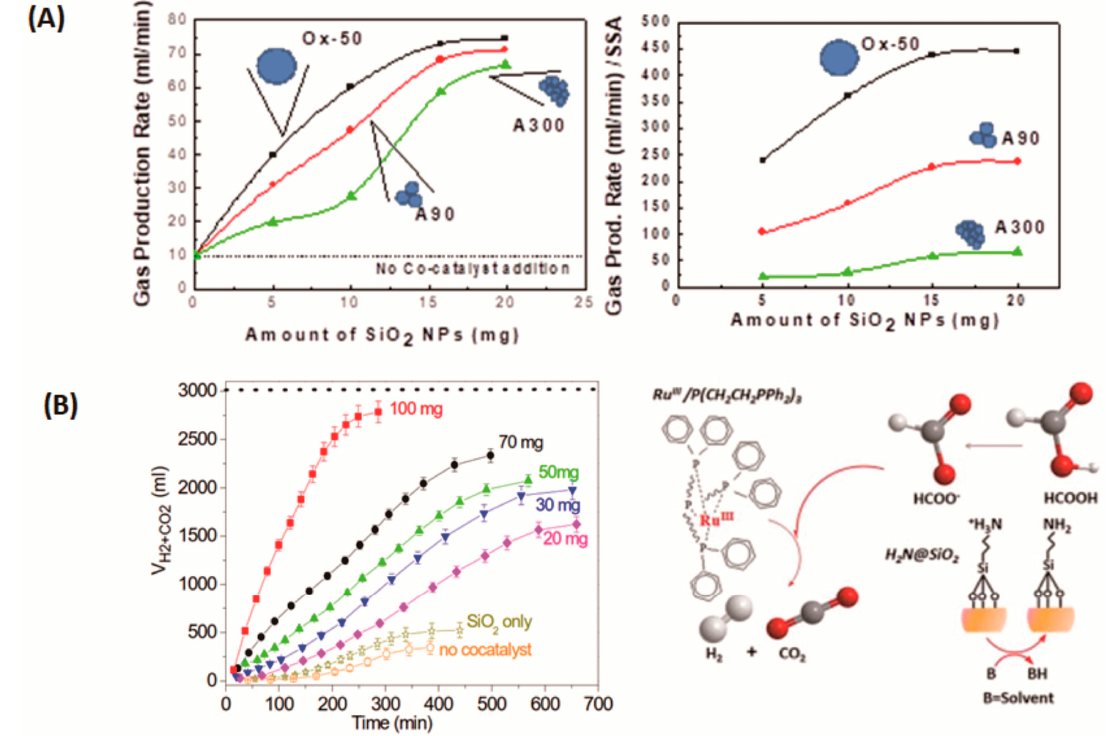
Figure 13. ( A ) E ff ect of SiO 2 NPs on the catalytic e ffi ciency of Fe / PPh 3 system. Figure adapted from Figure 13. ( Α ) Effect of SiO 2 NPs on the catalytic efficiency of Fe/PPh 3 system. Figure adapted from Reference [54]. ( B ) E ff ect of amino functionalized SiO 2 NPs on the catalytic e ffi ciency of Ru / PPh 3 Reference [54]. ( Β ) Effect of amino functionalized SiO 2 NPs on the catalytic efficiency of Ru/PPh 3 system. Figure adapted from Reference system. Figure adapted from Reference [24] .